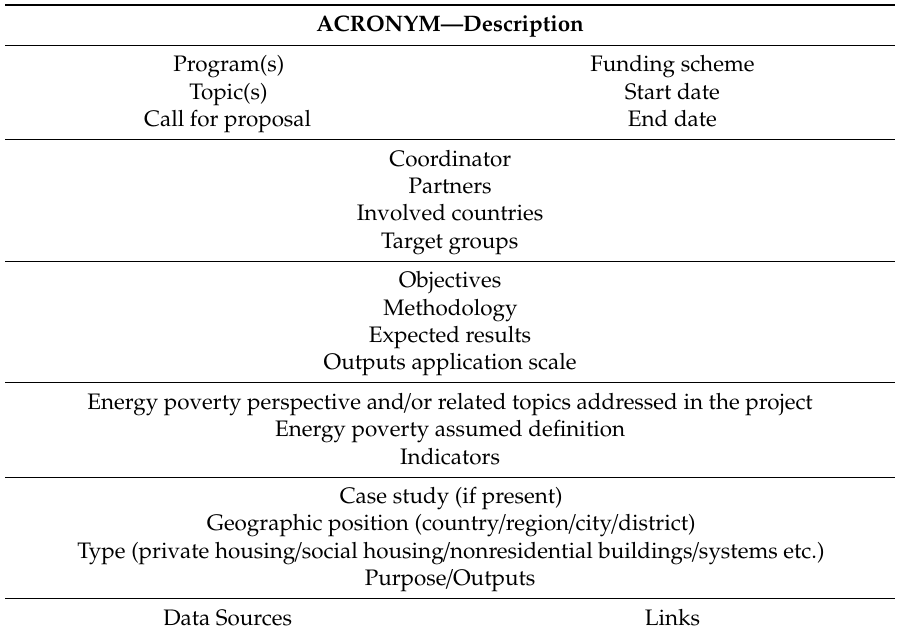
Table 1. Project factsheet content